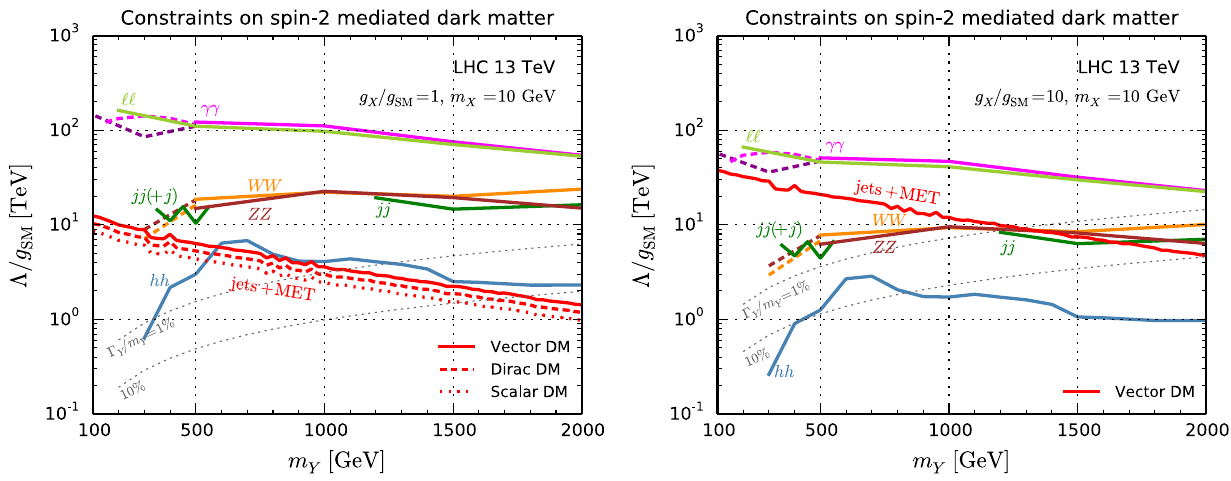
Fig. 10 Summary of the constraints on Λ/ g SM from searches with and without missing energy at the 13 TeV LHC as a function of the spin- 2 mediator mass, for m X = 10 GeV with g X / g SM = 1 ( left ) and 10 ( right ). The labelling of the constraints from resonance searches is the same as in Fig. 9. For g X / g SM = 1 the differences among the different